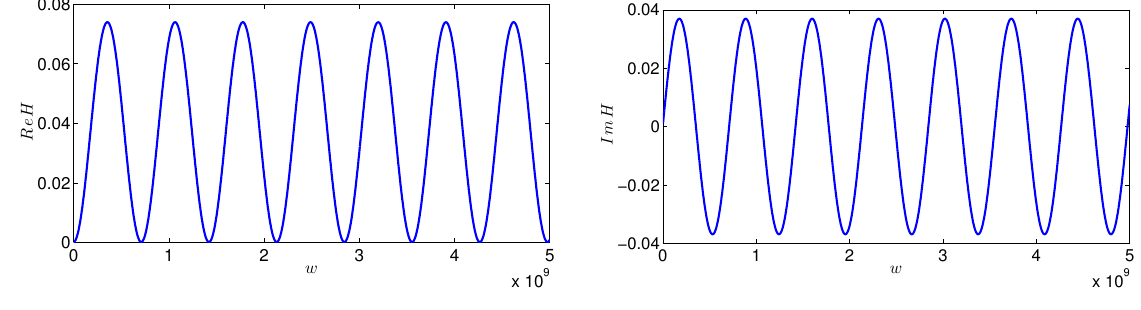
Figure 10. Re H ( w ) and Im H ( w ) in the transmission line example. The error curves for different M are shown in the left panel of Figure 11, indicating that the reconstruction error decreases quickly as M increases and reaches the level close to machine precision at M = 600 .